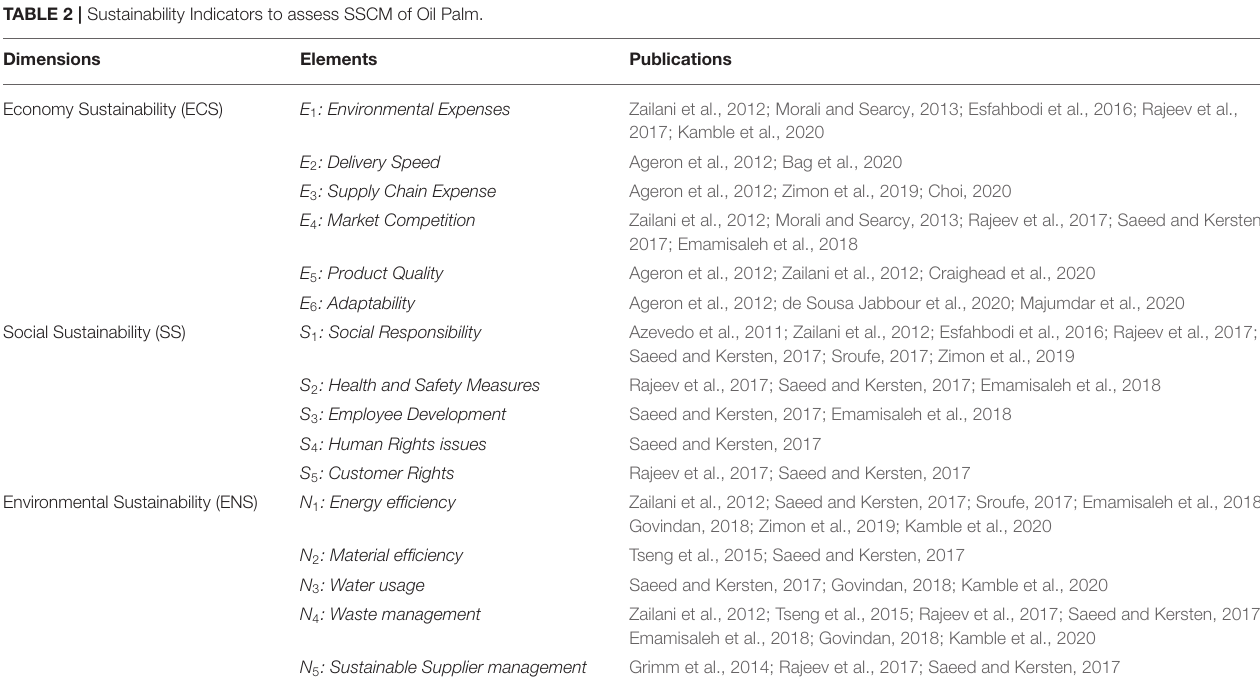
TABLE 2 | Sustainability Indicators to assess SSCM of Oil